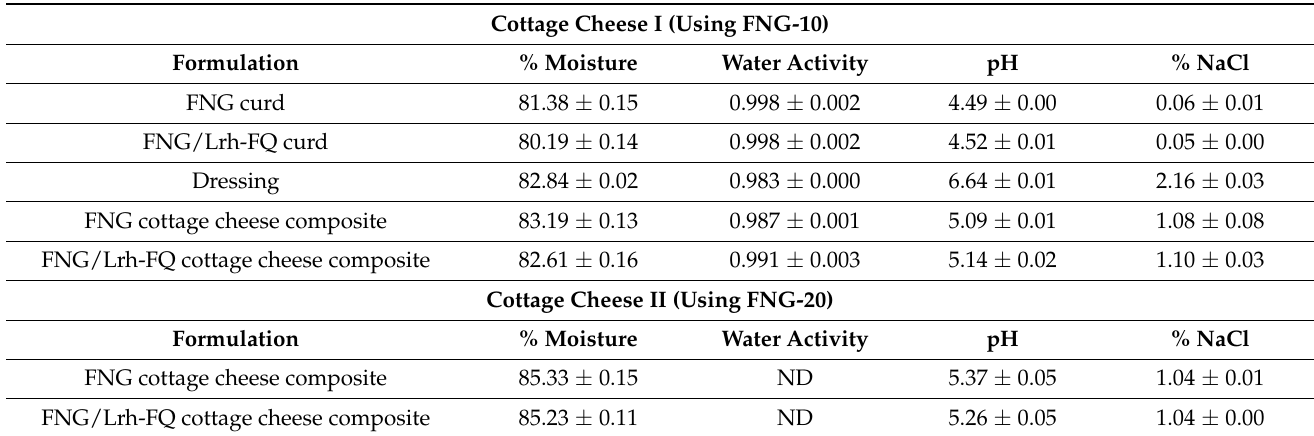
Table 3. Proximate analysis of cottage cheeses prepared and used in this study. Cottage Cheese I (Using